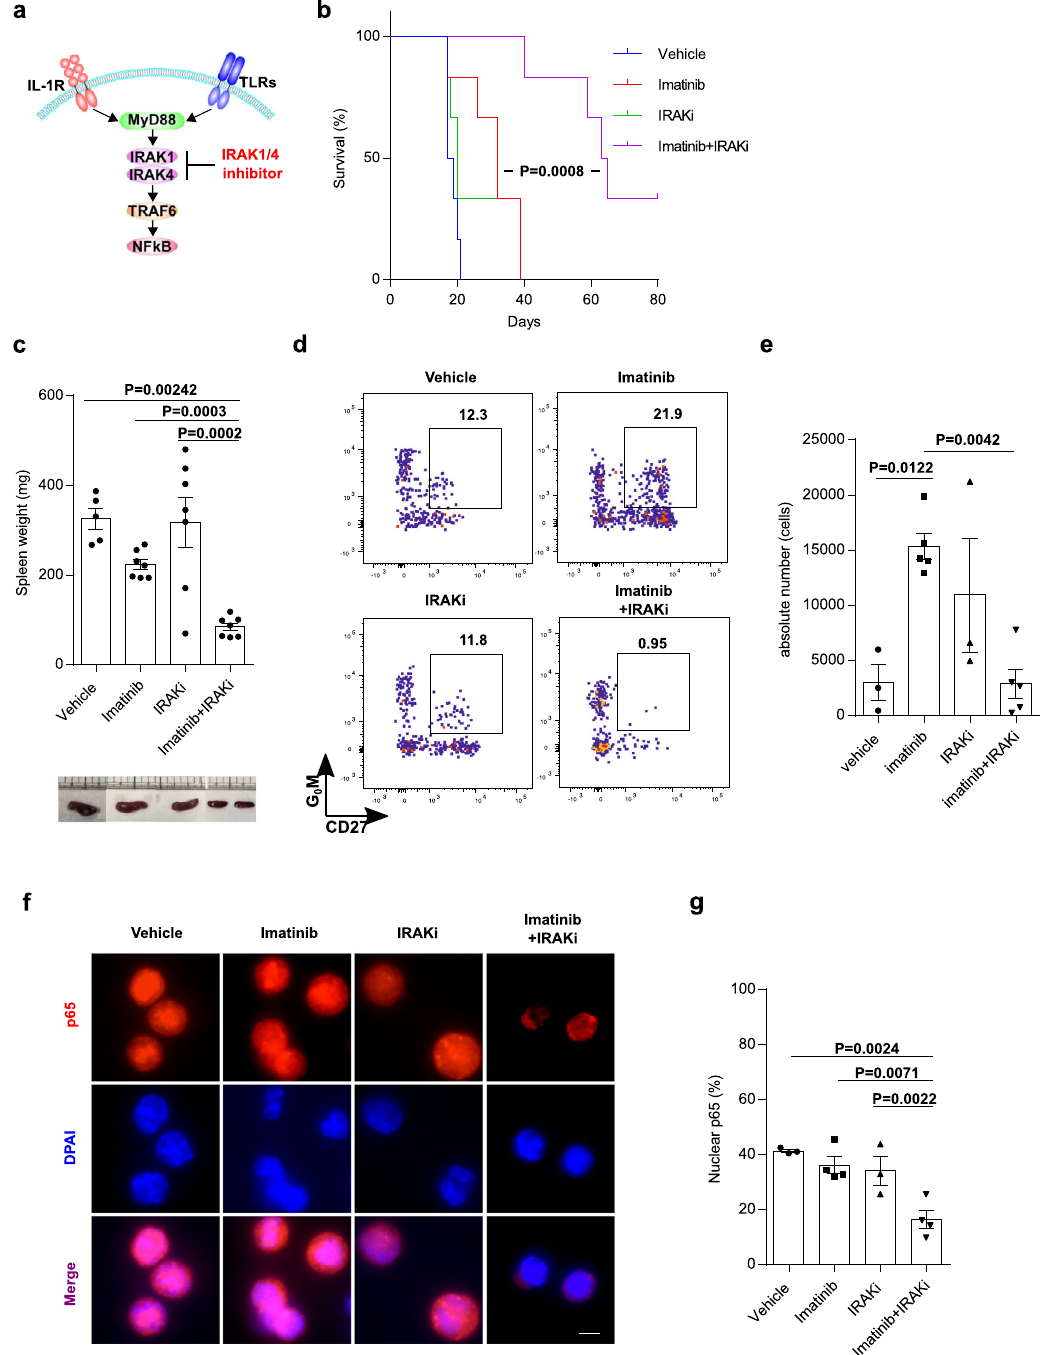
Fig. 3 IRAK1/4 inhibitor together with imatinib eliminates CML LSCs. a The IL1R/TLR-IRAK1/4 signaling pathway. b Survival curves for mice treated with vehicle, imatinib, IRAK1/4 inhibitor (IRAKi (R930259 Diet): 100 ppm) and the combination ( n = 6 each). c Spleen weights of CML mice treated with vehicle ( n = 5), imatinib ( n = 7), IRAKi ( n = 7), and the combination ( n = 7). Representative spleens are shown in the bottom. d Representative FACS plots of BCR-ABL1 + Lin − Sca1 + c-Kit + cells in the BM for all treatment conditions. e Absolute number of LSCs (G 0 M + CD27 + cells in FACS plots in D) in the BM from CML mice treated with vehicle ( n = 3), imatinib ( n = 5), IRAKi ( n = 3), and the combination ( n = 5). f p65 localization in sorted DP cells as CML LSCs for all treatment conditions. g Quanti fi cation of nuclear p65 in sorted DP cells as CML LSCs from CML mice treated with vehicle ( n = 3), imatinib ( n = 4), IRAKi ( n = 3), and the combination ( n = 4). Scale bar, 5 µ m. All treatments were continued during the observation period. All measurements in c – g were performed on days 18 – 20 after transplants. Data are shown as the mean ± SEM. P values are calculated using log-rank test ( b ) or one-way ANOVA with Tukey ’ s correction for multiple comparisons ( c , e , g ).